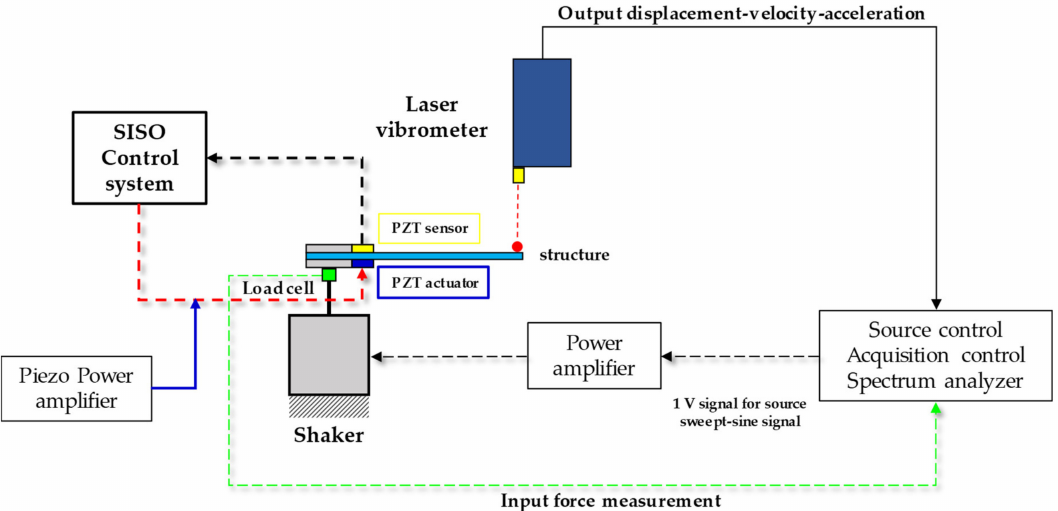
Figure 13. Diagram of the test equipment and control system.